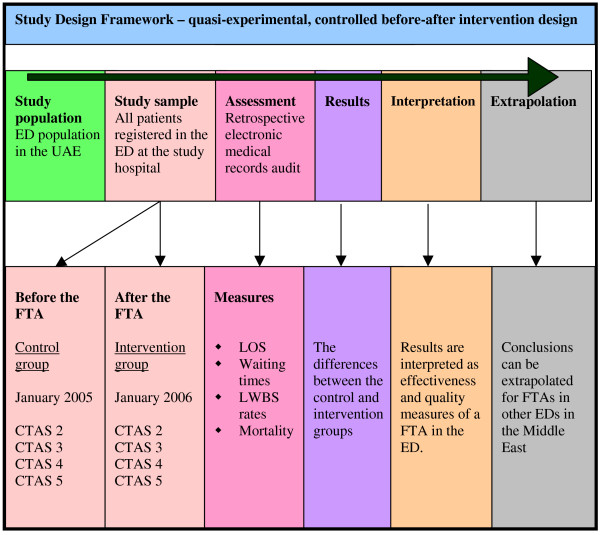
Framework of this study's design.